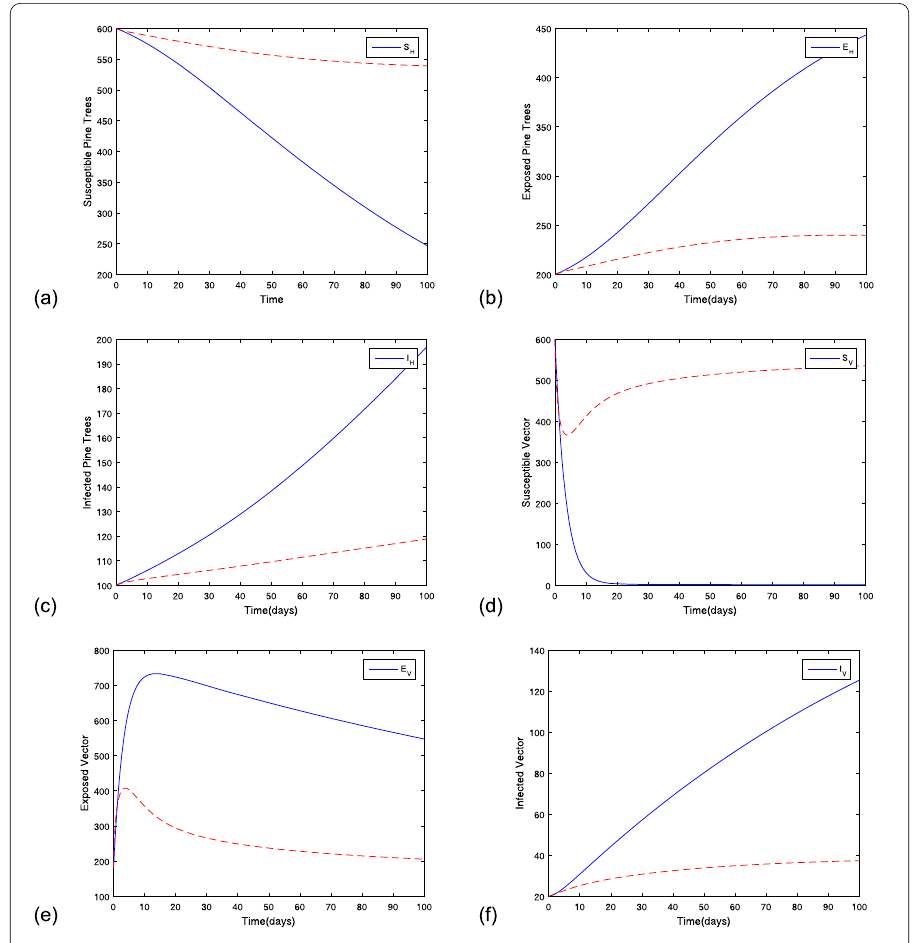
Figure 3 Simulations of pine tree population ( a )–( c ) and vector population ( d )–( f ) of the FPWD model (9) for τ = 0.6. ( a ): Susceptible pine tree; ( b ): Exposed pine tree; ( c ): Infected pine tree; ( d ): Susceptible vector; ( e ): Exposed vector; ( f ): Infected